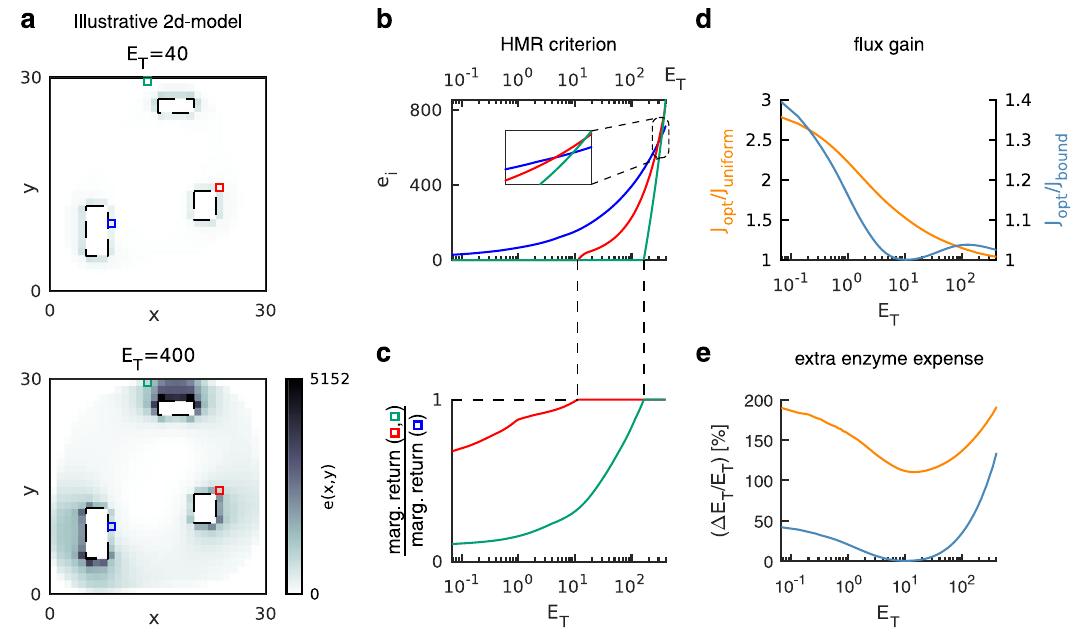
Fig. 5 Two-dimensional model system to illustrate the HMR criterion and the application of the additive construction scheme for optimal enzyme arrangements. The system has an absorbing outer boundary and three inner compartments that act as substrate sources (dashed rectangles). a Optimal enzyme density e ( x , y ) (grayscale) at two different total enzyme amounts ( E T = 40 and 400), calculated using the construction scheme. The colored squares indicate positions at which e ( x , y ) is analyzed in b , c as a function of E T , to illustrate the HMR criterion. b Optimal enzyme densities and c ratios of marginal returns at the positions indicated by colored squares in a . When a ratio of marginal returns reaches one, a new position becomes occupied with enzymes (correspondence marked by dashed lines). d The fl ux gain of the optimized enzyme arrangement ( fl ux J opt ) relative to a uniform arrangement ( J uniform , orange) and a fully bound arrangement ( J bound , cyan), as a function of E T . The fl ux J uniform is produced by uniformly distributing the enzymes in the whole system, whereas J bound is for all enzymes evenly distributed over the boundaries of the substrate sources. e Percentage of extra enzymes, Δ E T / E T , required in the uniform (orange) and bound (cyan) con fi guration to obtain the same fl ux as the optimal enzyme arrangement, as a function of E T